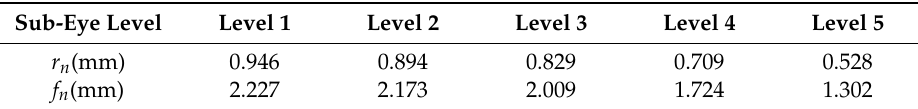
Table 2. Calculated initial parameters of subocular